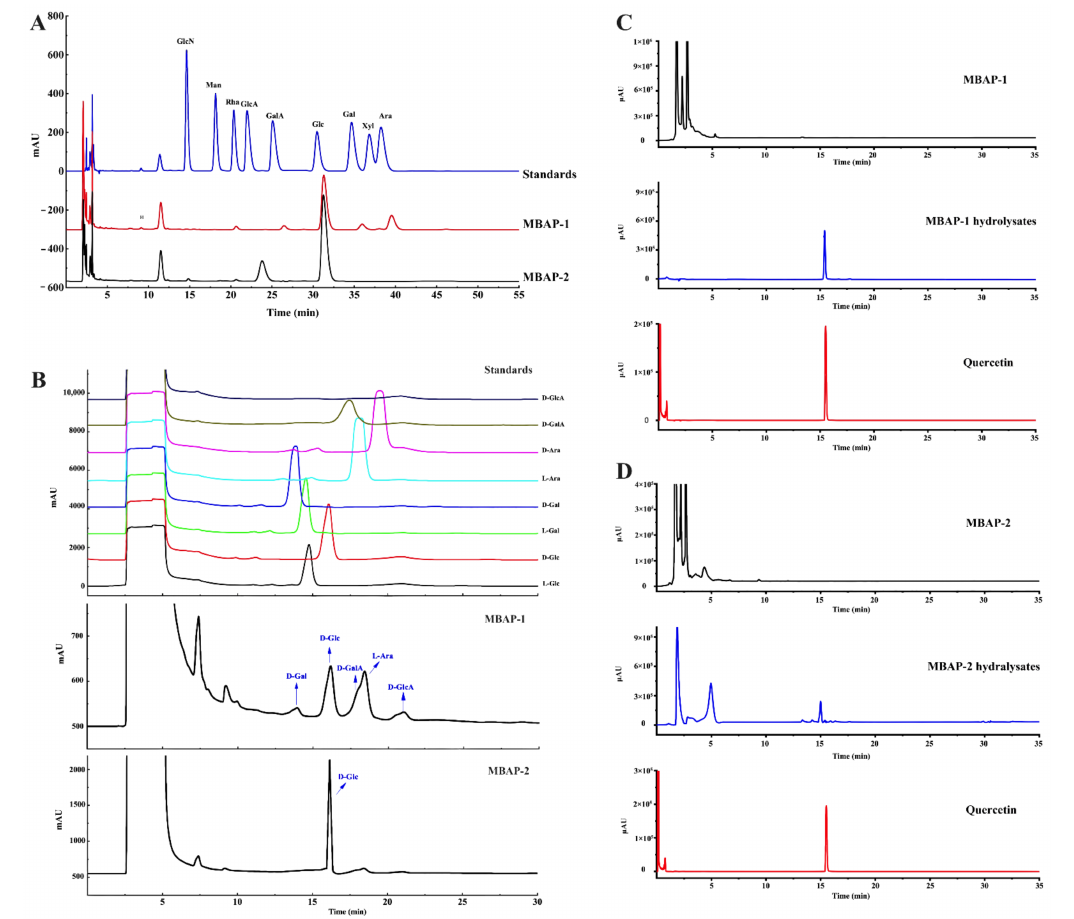
Figure 2. The chromatograms of monosaccharide composition ( A ), monosaccharide absolute configu- ration analysis ( B ) and UPLC-MS identification results of substituted flavonoids ( C , D ) of MBAP-1 and